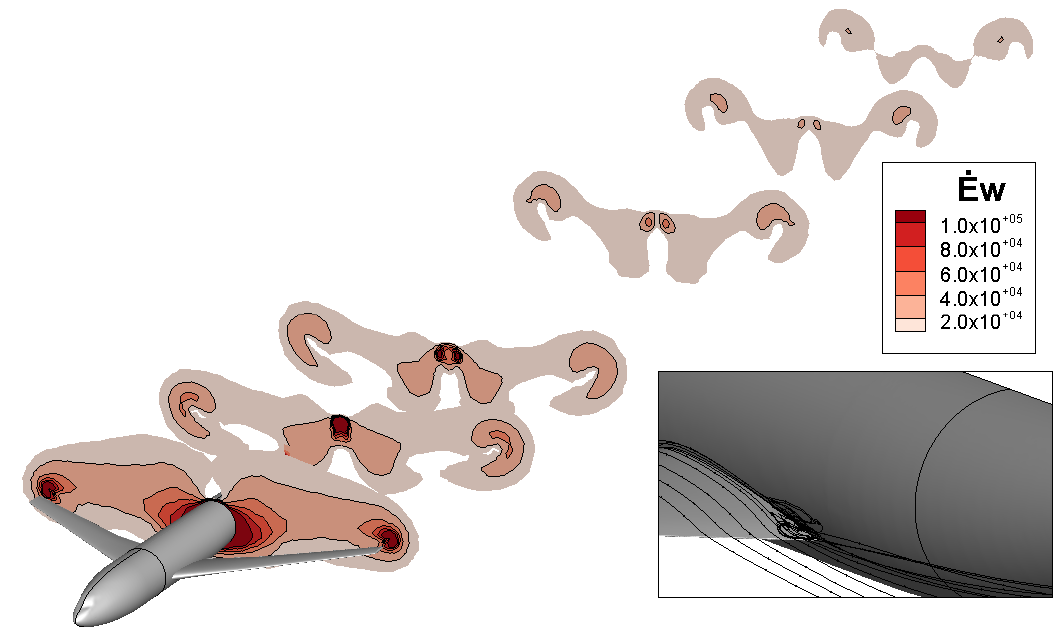
Figure 12. Contours of the ˙E w integrand around the wing body configuration. Viscous dissipation, Φ , is the sink term of power. As elaborated in Section 2.1, it ex ‐ ists in the viscous region (boundary layer and wake) where the velocity gradient exists. field. A high intensity of Φ was observed in the region over the airframe surface and in the downstream wake. In the downstream wake, the intensity of Φ in the body wake was higher than that of the wing wake. Compared with the wing wake, the body wake might be less stable, and its mechanical energy dissipated at a faster pace. This study visualized the change in power terms by placing their values at the cor ‐ responding X coordinates, as shown at the bottom of Figure 13. This plot illustrates how the power conversion process occurred in the flow field: drag power, DV ∞ , was trans ‐ ferred into wake power, E • w , as well as viscous dissipation, Φ .